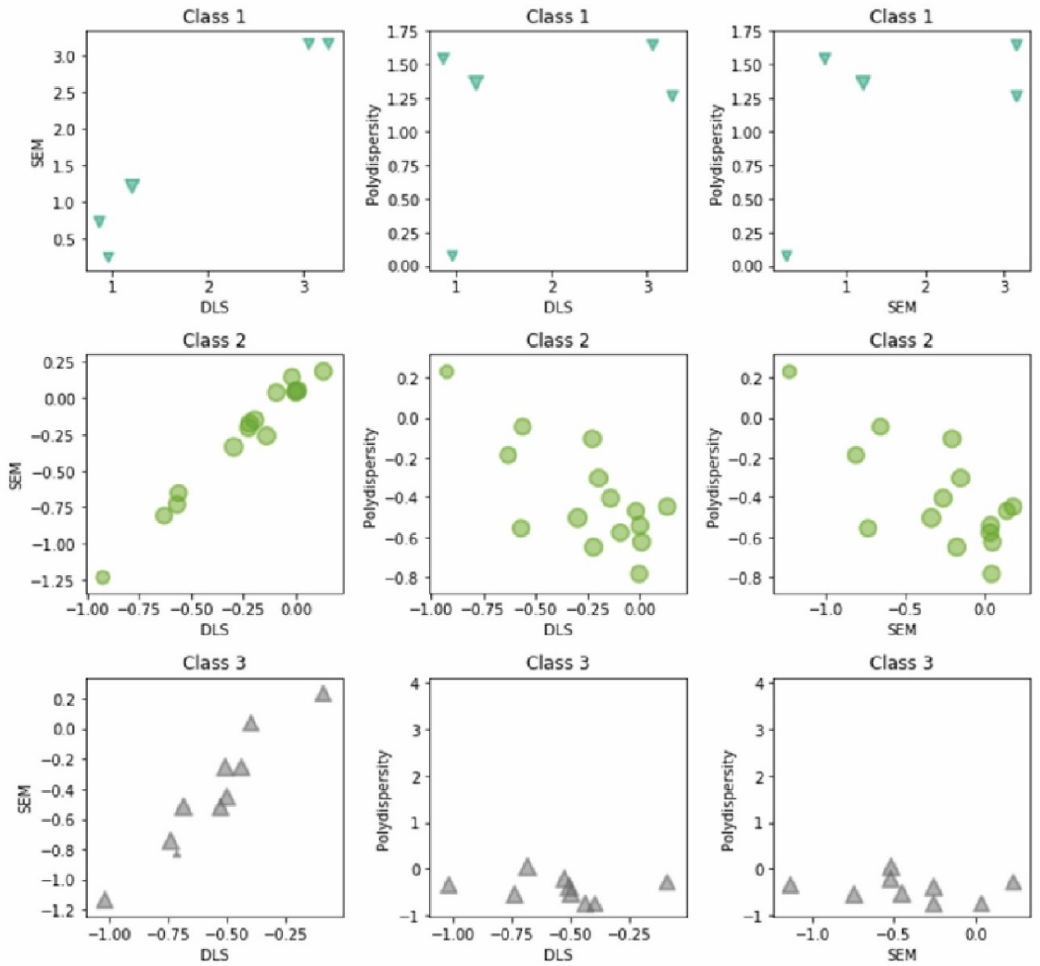
Figure 9. A 2D representation of each class obtained by statistical analysis. The axes show the position of each experiment in the space, read out of the K-means plot.